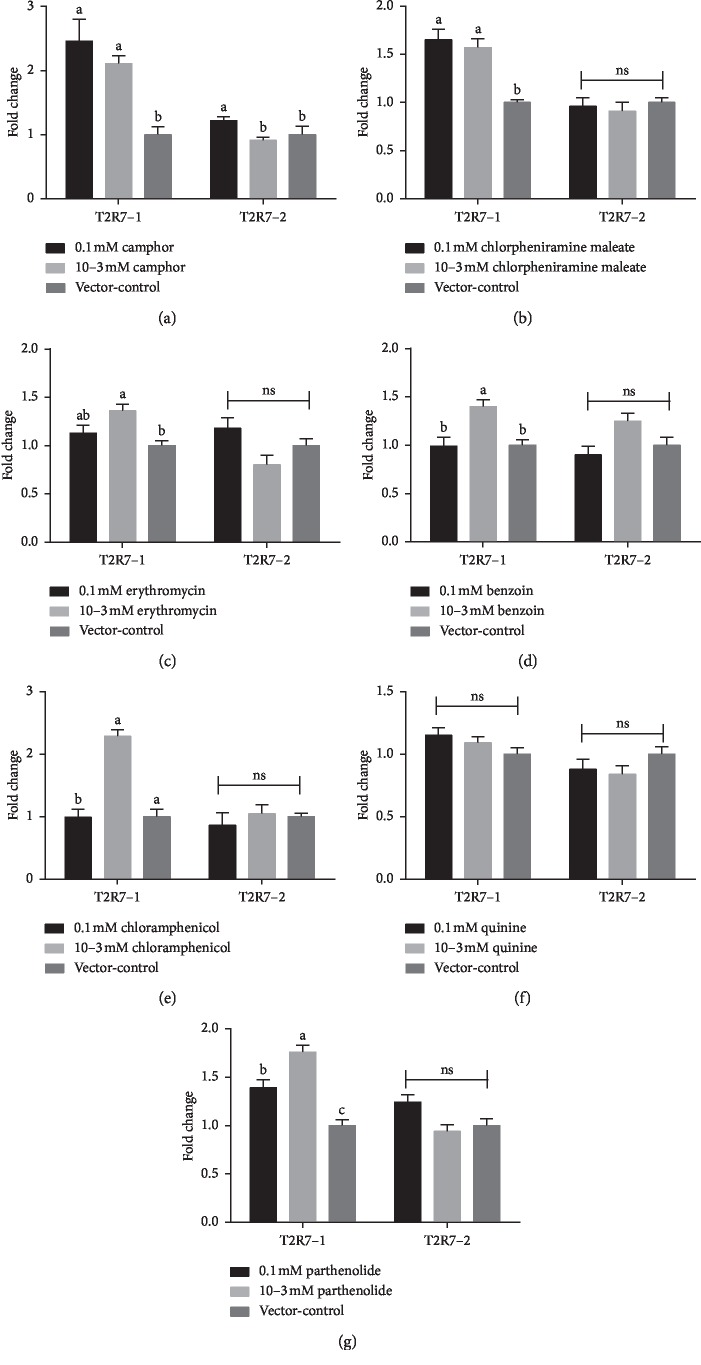
Relative expression levels of PLCβ2 mRNA in cT2R7-1/pDisplay-Gα16/gust44/pcDNA3.1 (+) and cT2R7-2/pDisplay-Gα16/gust44/pcDNA3.1 (+) cells stimulated by different concentrations of (a) camphor, (b) chlorpheniramine maleate, (c) erythromycin, (d) benzoin, (e) chloramphenicol, (f) quinine, and (g) parthenolide, as determined by real-time PCR. The relative gene expression was measured by qPCR and normalized to GAPDH, and the vector-control was the negative control. Each bar represents the mean ± SE of the results from 2 to 3 independent experiments performed in triplicate. Different small letters on the bar indicate significant differences at P < 0.05.